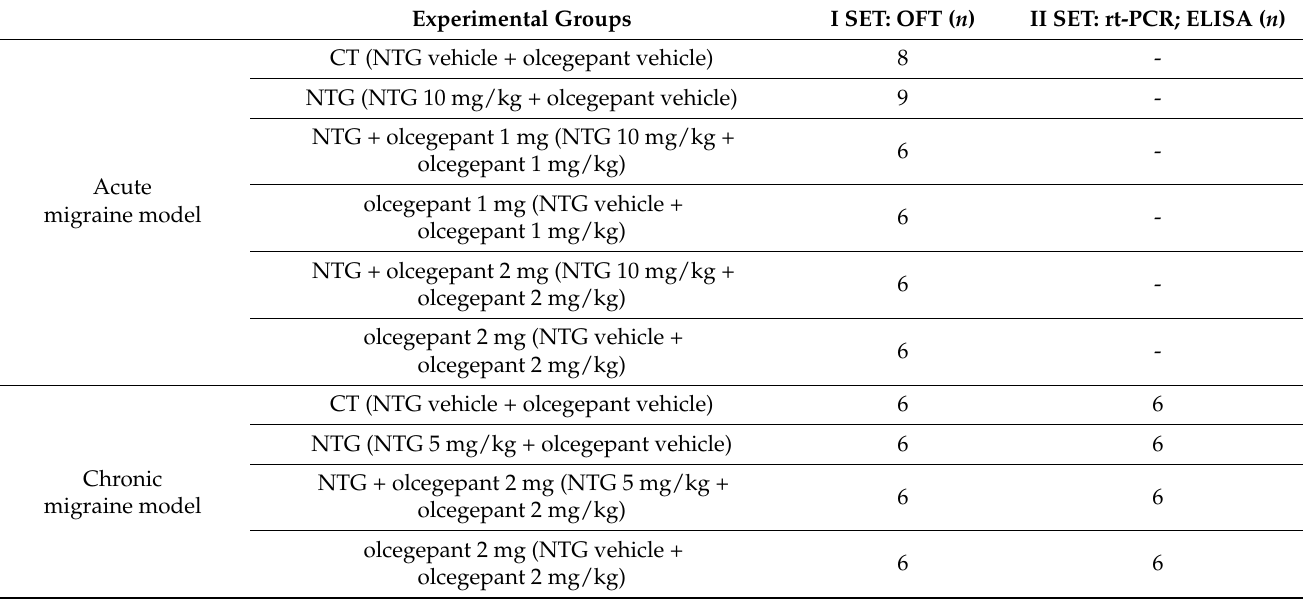
Table 1. Experimental groups. Experimental Groups I SET: OFT ( n